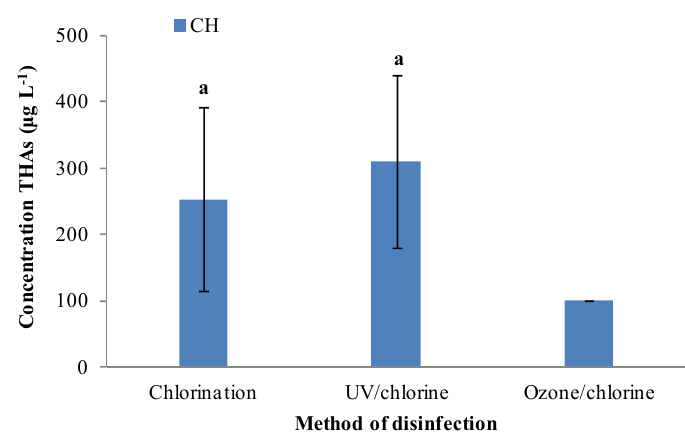
Figure 4. Mean and standard deviation of THAs with different methods of disinfection. Note: “ a ” shows that chlorination and UV/chlorine are not significantly different at α = 0.05 ( p < 0.05). Statistical analysis to compare the means in the case of ozone/chlorine was not carried out because of fewer data points.